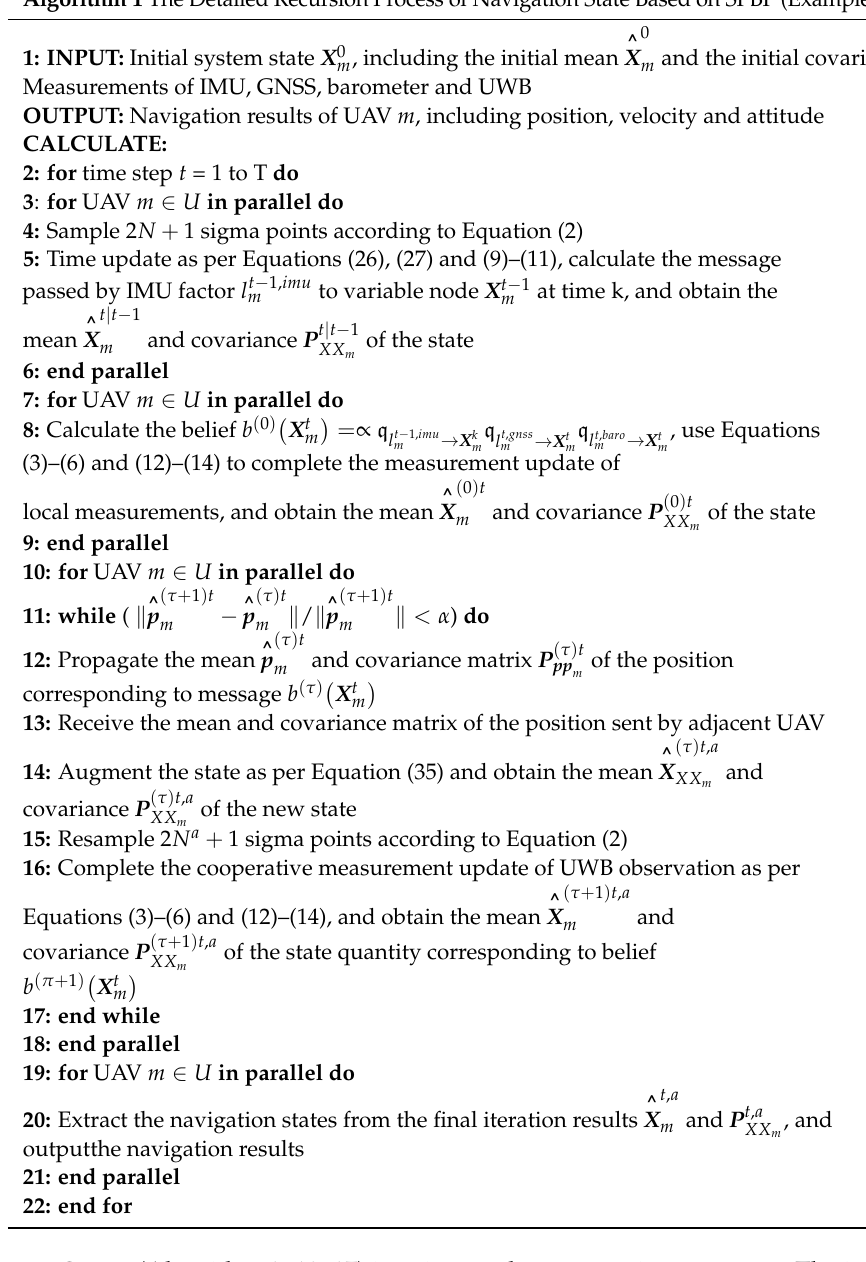
Algorithm 1 The Detailed Recursion Process of Navigation State Based on SPBP (Example of UAV m